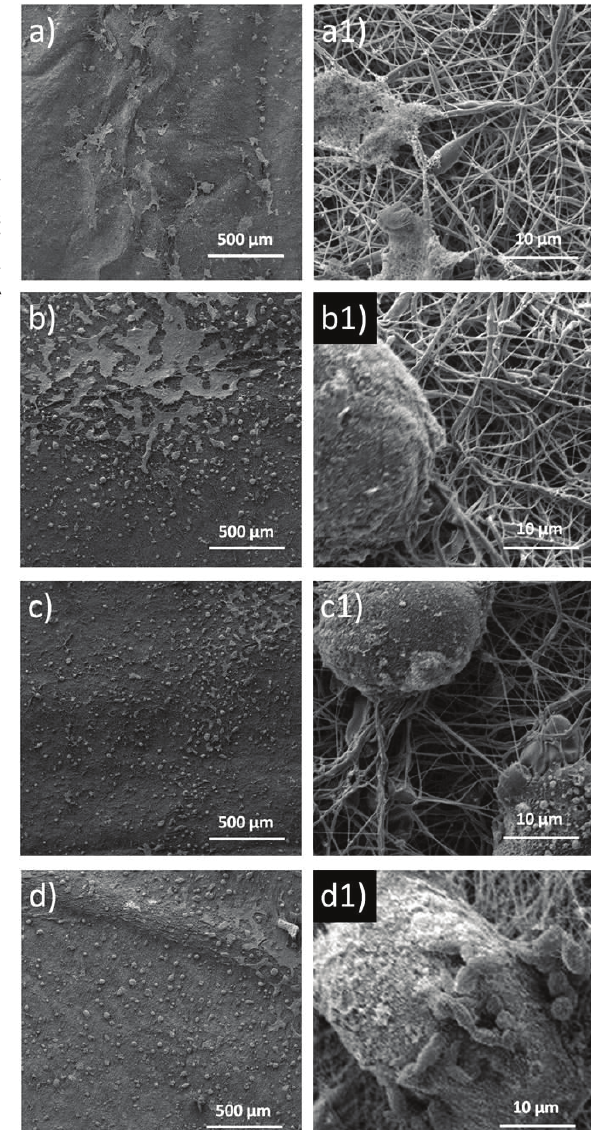
Fig. 9 – SEM images of the electrospun scaffolds cultured with HaCaT cells 72 hours after cell seeding,